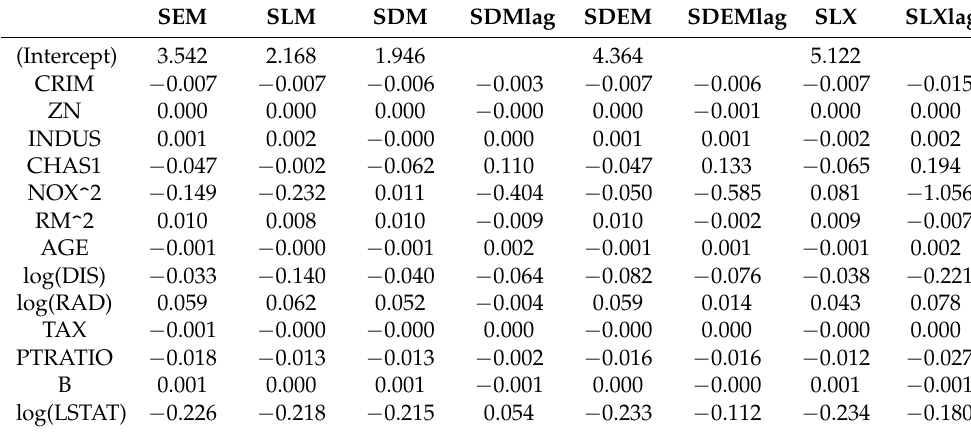
Table 1. Posterior means of the fixed effects coefficients, Boston housing